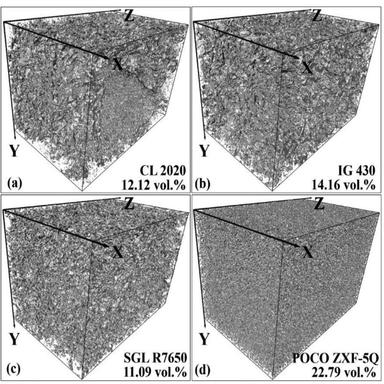
Porosity volume in four grades of graphite: (a) CL 2020 graphite, total volume (X, Y, Z): 1200 × 1200 × 1864 voxel3, voxel size: 0.20 × 0.20 × 0.20 μm3, (b) IG 430 graphite, total volume: 1200 × 1200 × 1878 voxel3, voxel size: 0.21 × 0.21 × 0.21 μm3, (c) SGL R7650 graphite, total volume: 1200 × 1200 × 1895 voxel3, voxel size: 0.19 × 0.19 × 0.19 μm3 and, (d) POCO ZXF-5Q graphite, total volume: 1200 × 1200 × 1883 voxel3, voxel size: 0.21 × 0.21 × 0.21 μm3. The total volume rendered for each graphite is equiva